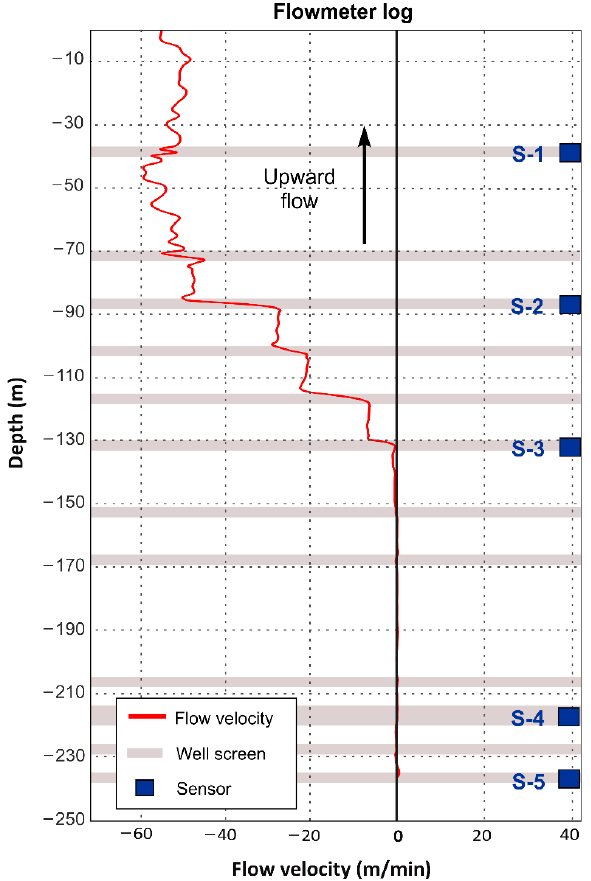
Figure 5. Vertical flow velocity estimated from flowmeter logs in well W250.